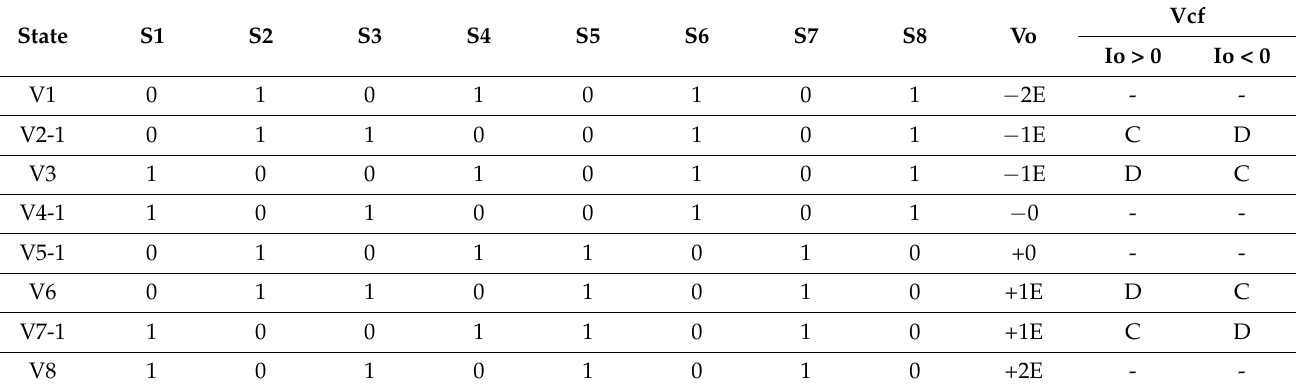
Table 1. Traditional switching states of the ANPC-5L